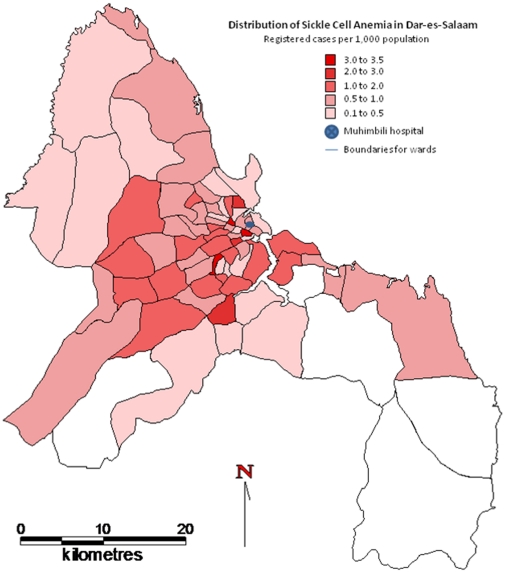
The geographical distribution of registered SCA patients who live in Dar-es-Salaam.